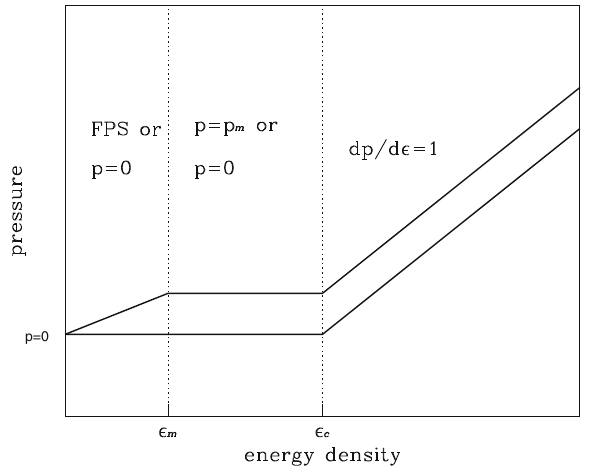
Fig. 3 Schematic representations of the minimum-period EOSs (85) and (92). For the minimum-period EOS (85) the pressure vanishes for (cid:19) < (cid:19) C . The minimum-period EOS (92) matches the FPS EOS to a constant pressure region at an energy density (cid:19) m . For (cid:19) > (cid:19) C both EOSs are at the causal limit with dp / d (cid:19) = 1. (Image reproduced with permission from Koranda et al. 1997, copyright by AAS)